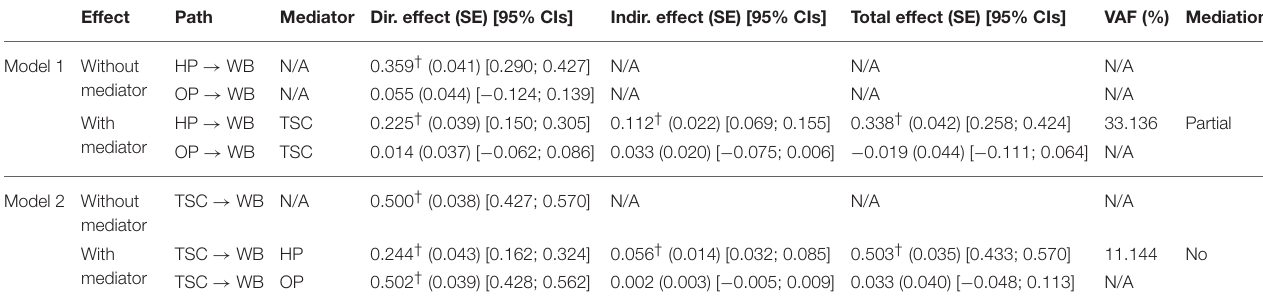
TABLE 5 | Mediation analysis for the two